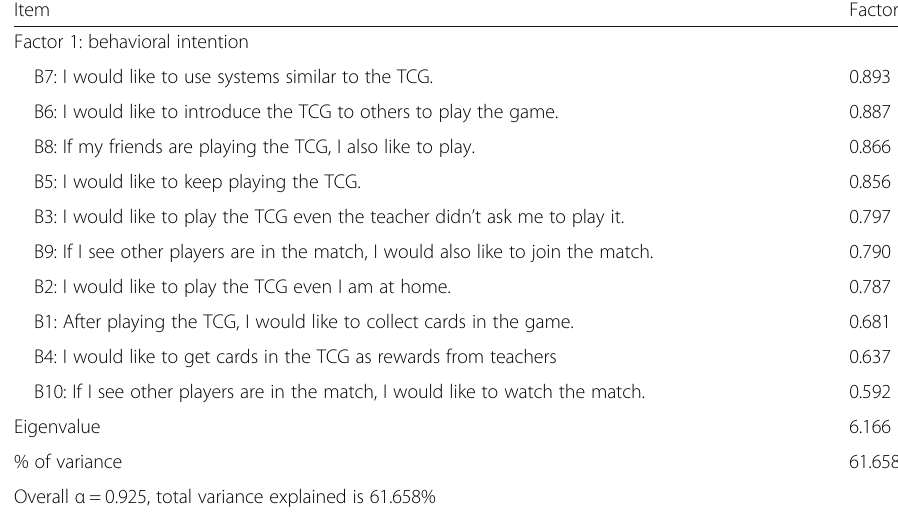
Table 4 Validity analysis results of the Behavioral Intention factor only revised TAM questionnaire Item Factor 1